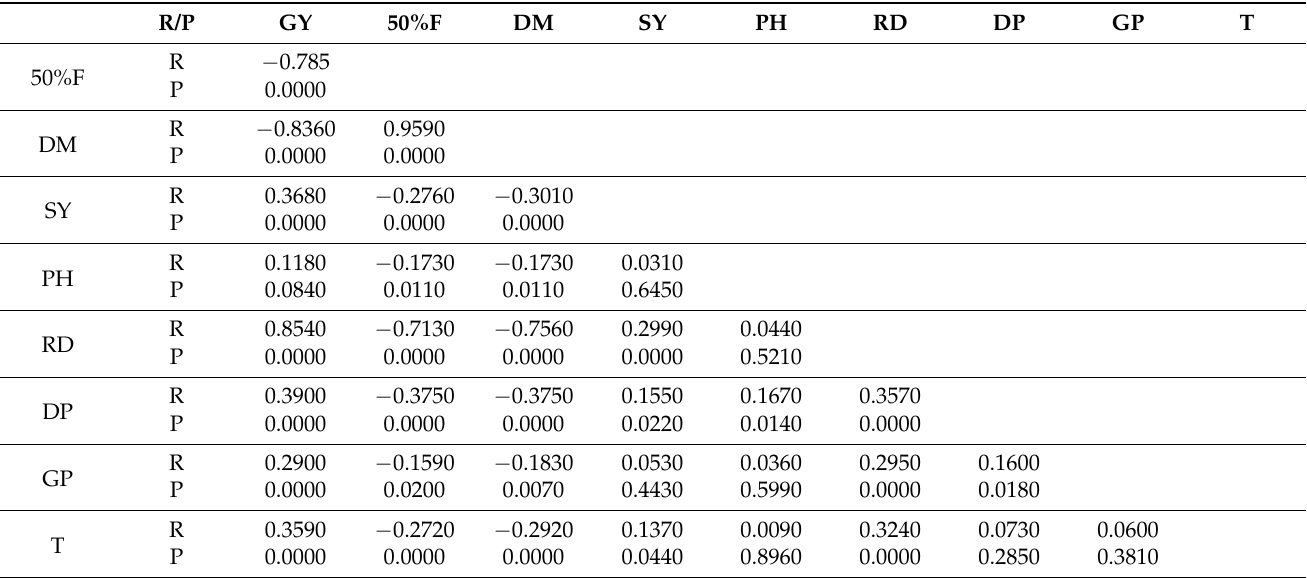
Table 8. Correlation coefficients between yield, days to maturity, resistance to diseases, and pro- cessing characteristics of 54 sorghum varieties in Yaguine, Gory, and Foungou in the 2013/2014 cropping season.